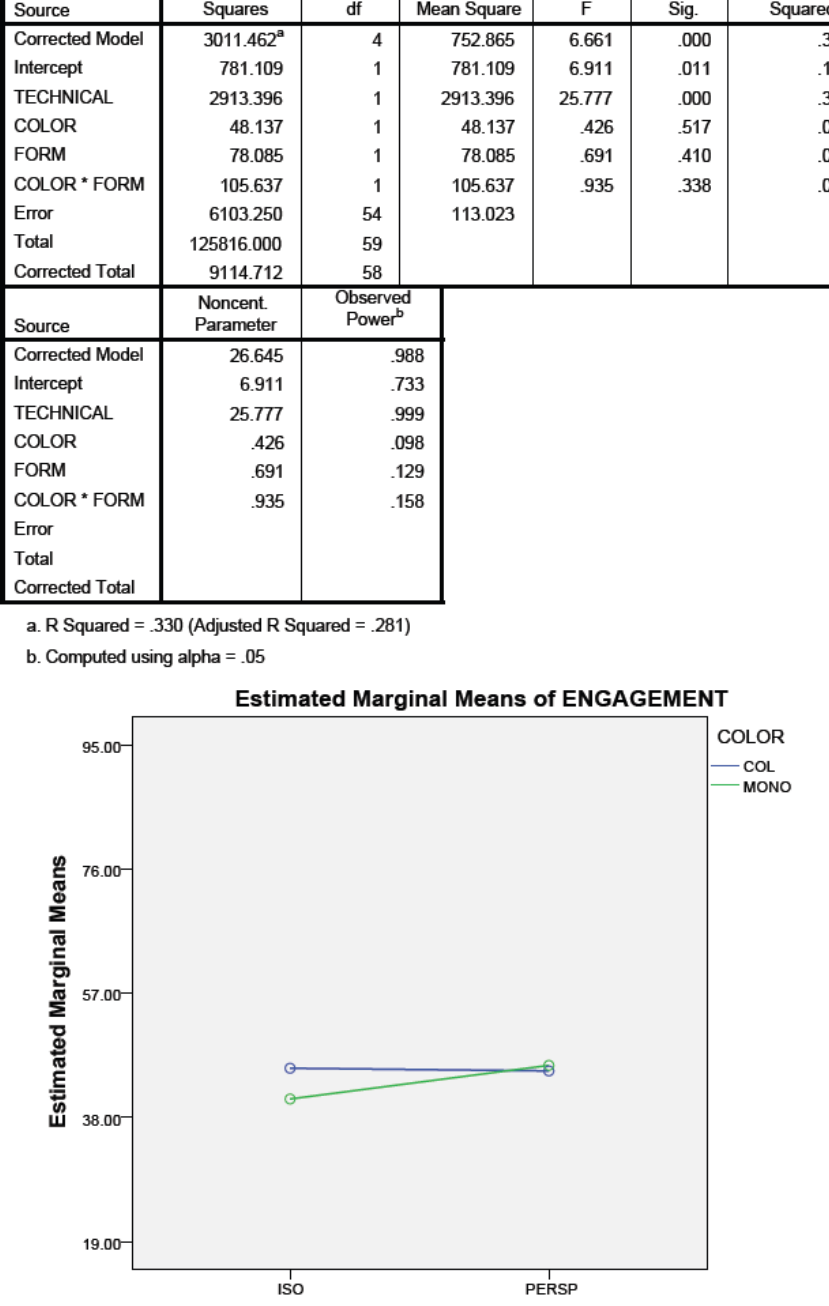
Figure B.9. ANCOVA analysing engagement levels for the main and interaction effects of color and form using data adjusted for technical performance for participants who correctly indicated their